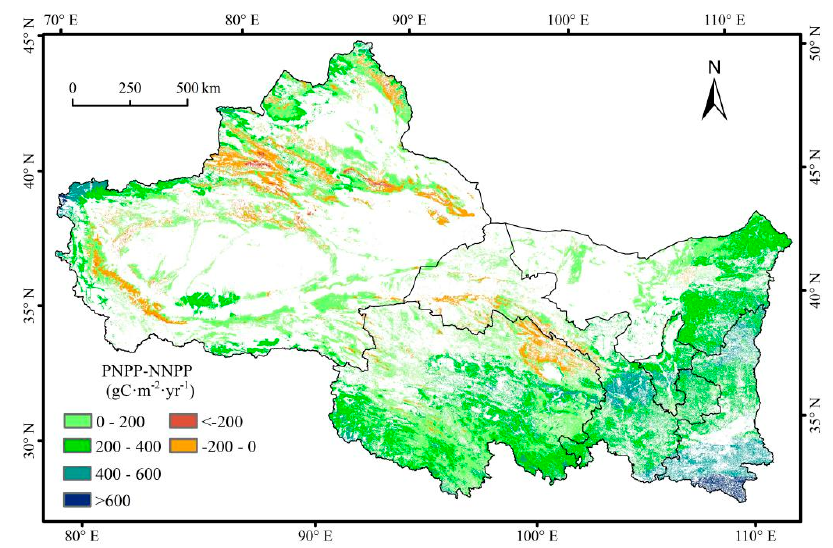
Figure 15. Spatial distribution of difference between PNPP and NNPP.